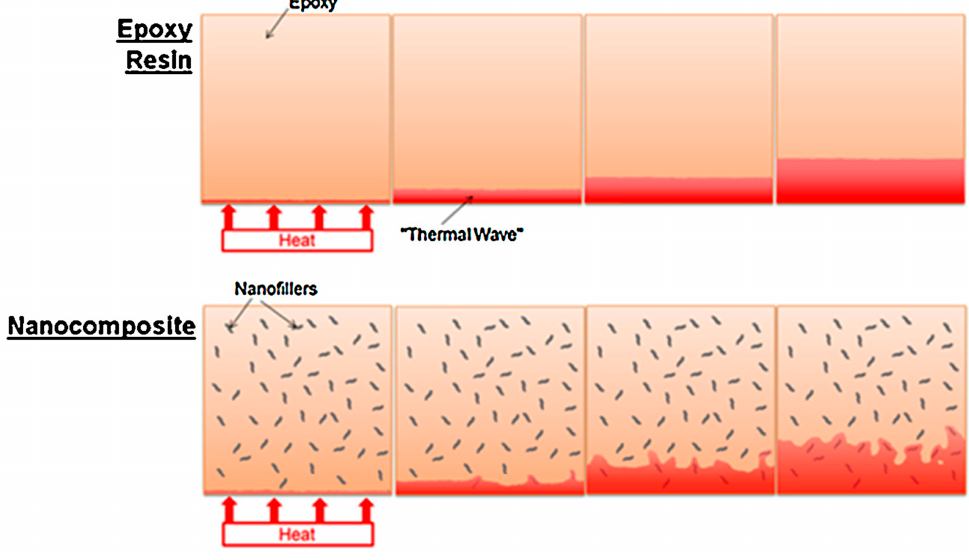
Figure 3. Thermal conductivity by graphene in a graphene-polymer composite [29]. Copyright (2016), with permission from Elsevier.